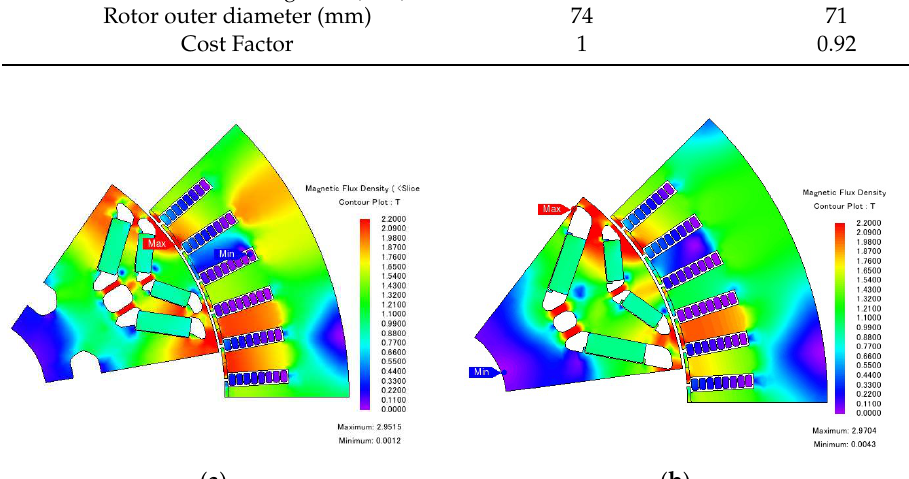
Figure 14. Comparison of magnetic field distribution. ( a ) Initial model; ( b ) optimized model. Then, efficiency map simulation analysis is conducted, and the efficiency contour of 96% moves to the low torque and low speed direction after the multiobjective optimiza- tion. The red region accounts for a large proportion in CLTC cycle, which speed range is 2,000 rpm–5,000 rpm and torque range is 20 Nm–75 Nm. As shown in the Figure 1 5 , the high-efficiency contour moves in this direction, and the CLTC efficiency is improved.